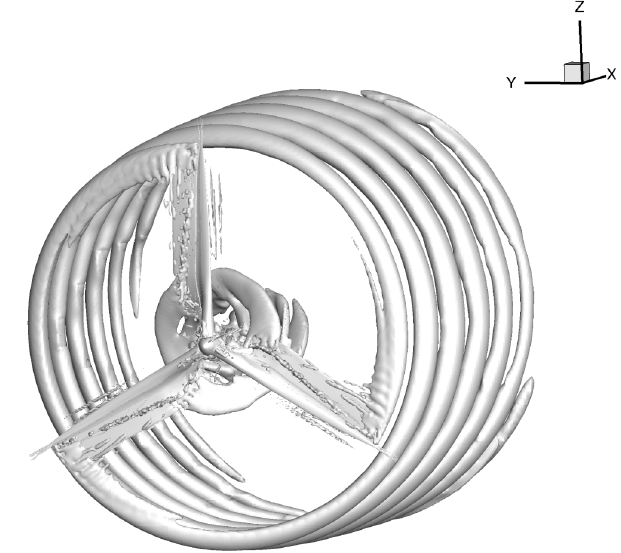
Figure 5. Visualisation of the horizontal wind measurements at dif- ferent flight leg altitudes (from 85 to 185m above ground in 20m steps) and different distances to the WEC (1, − 1, − 2 and − 4D). Significant wind deficit 1D behind the WEC E-112. On this day, the wind direction was about 30 ◦ north. Image generated in © Google